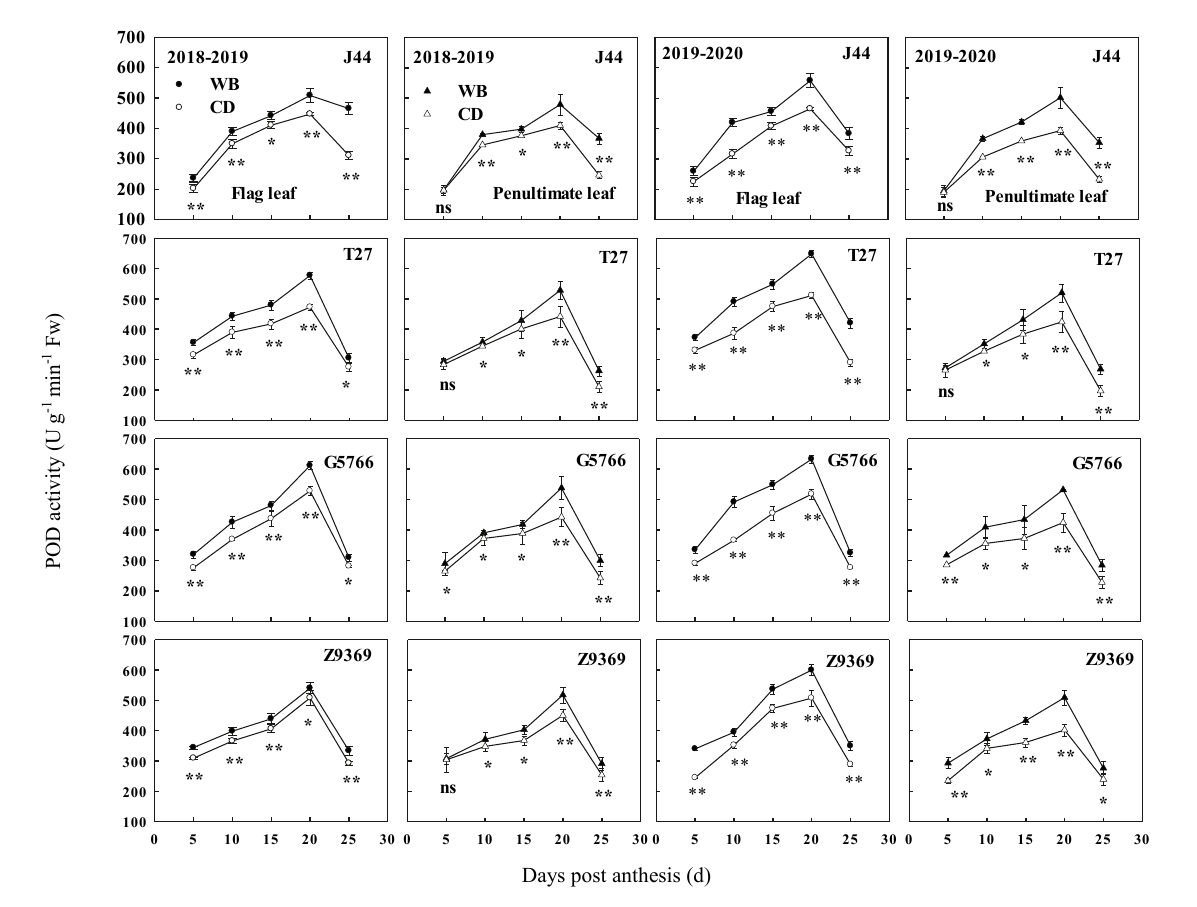
FIGURE8 Effects of sowing pattern on peroxidase (POD) activities of the flag leaf and penultimate leaf of bread wheat. Values are means of three replicates per treatment. Vertical bars indicate standard error. ns, *, and **Indicate significant differences at P ≥ 0.05, P < 0.05, and P < 0.01 between the two sowing patterns at each measurement time. CD and WB denote the conventional drilling and wide belt sowing pattern,